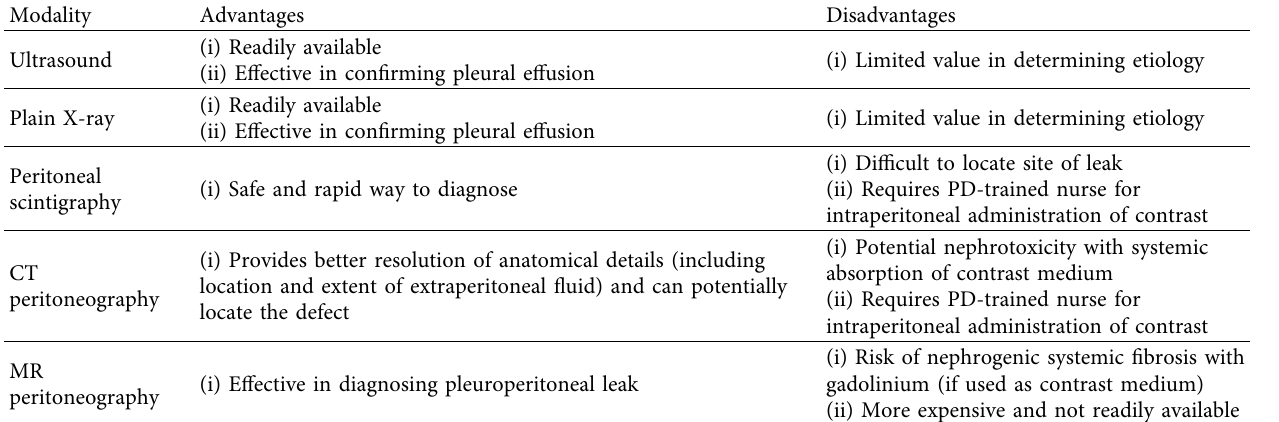
Table 3: Radiological modalities in diagnosing peritoneal-pleural